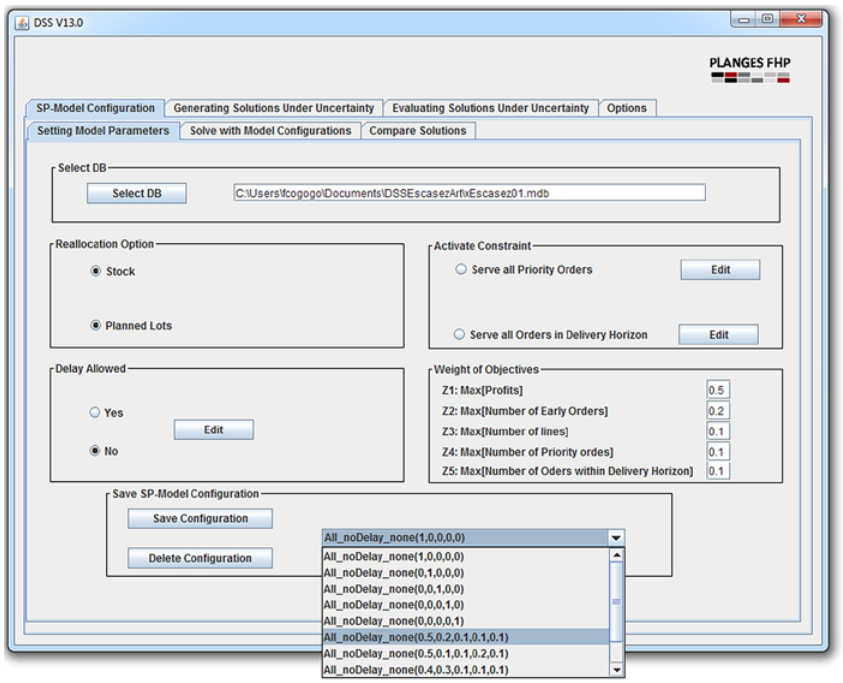
Fig. 3. The “Setting Model Parameters” DSS